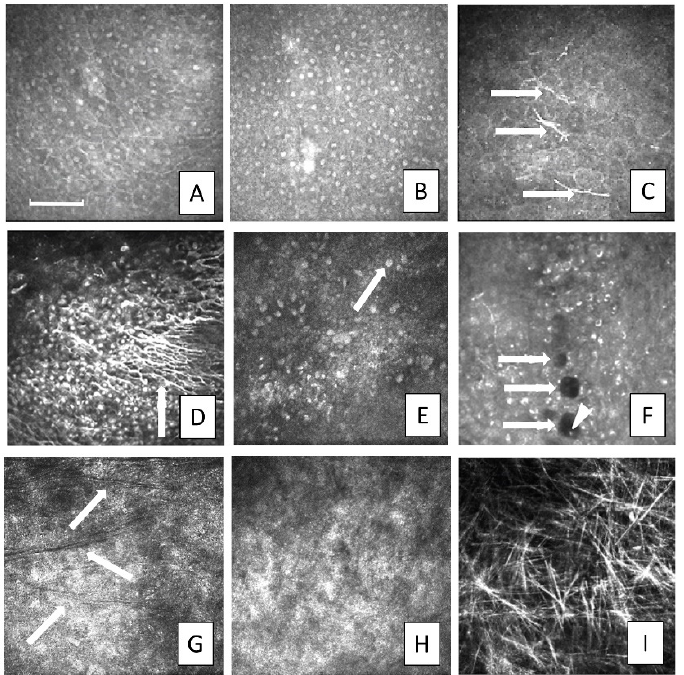
Figure 1. Preoperative In Vivo Confocal Microscopy findings of the corneal surface impaired by limbal stem cell deficit. ( A ) Superficial conjunctival cells populating the corneal surface, hyper-reflective, with bright nuclei and ill-defined borders. ( B ) Basal conjunctival cells with prominent nuclei and ill-defined borders. ( C ) Basal conjunctival cells with bright borders, dark cytoplasm, barely visible nuclei, and Langerhans cells visible among basal cells (arrows). A net of activated dendriform cells ( D , arrow). ( E ) Goblet cells are hyper-reflective, larger than surrounding epithelial cells, and round to oval in shape (arrow). ( F ) Microcysts (arrows) are specific to conjunctival pannus, and appear as round or oval dark shapes with bright borders; small, white, or grey spherical elements, likely mucin, can sometimes be detected inside the microcysts (arrowhead). ( G ) Bowman’s layer appears as dark folds overlying the anterior stroma (arrows) in patients with a history of keratoplasty. ( H ) Only bare stroma was detectable at that level in the remaining patients. ( I ) Stromal scarring is characterized by copious hyper-reflective needles in the mid-stroma, representing severe keratocyte apoptosis (images are 400 × 400 µm, the bar is 100 µm).